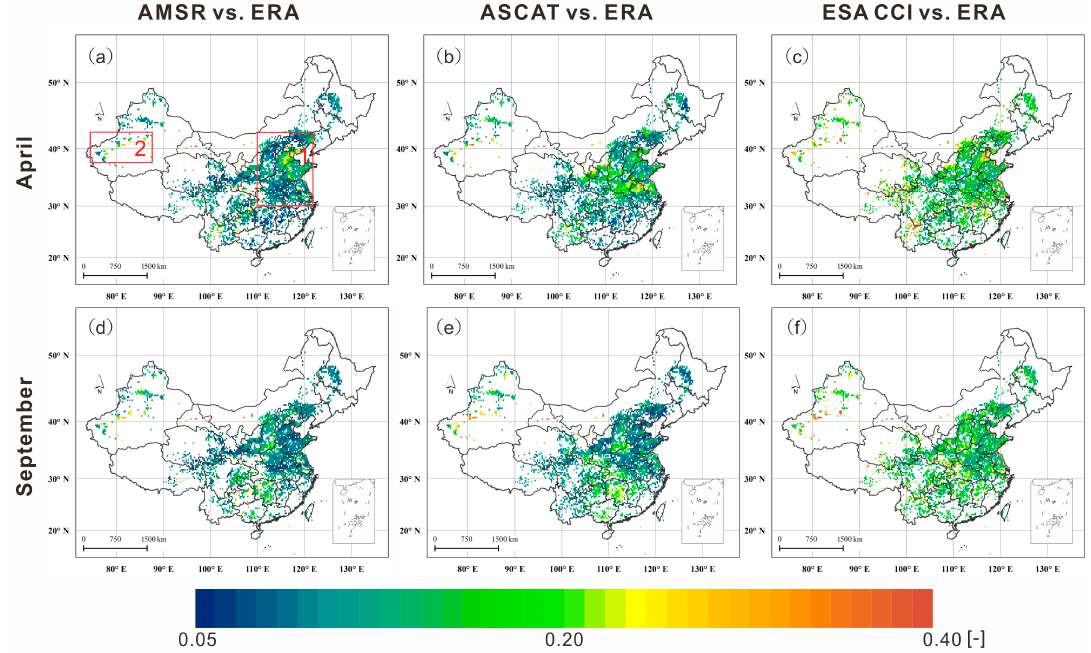
Figure 5. K-S metrics calculated from three remote sensing soil moisture retrievals and ERA-Interim: the first and second rows are for irrigation month of April and non-irrigation month of September, respectively, while the first to third columns show results for pairs of the Advanced Microwave Scanning Radiometer (AMSR) vs. ERA, the Advanced Scatterometer (ASCAT) vs. ERA, and ESA CCI vs. ERA respectively.